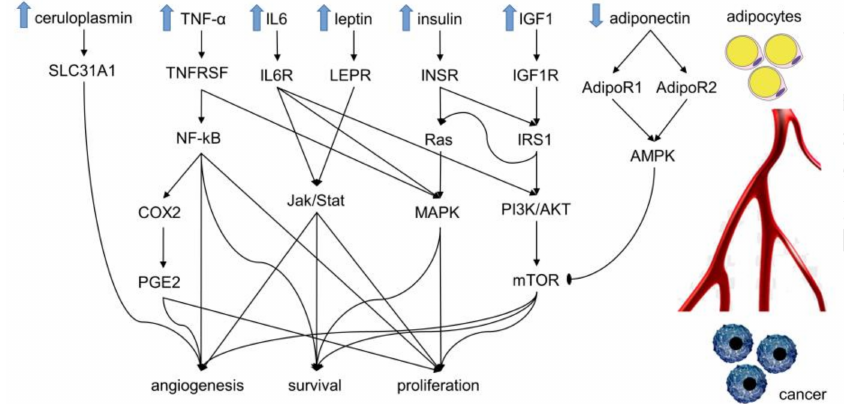
Figure 1. The pathway shows the influence of adipocytes on cancer. The arrows indicate induction or activation, the line ending with an oval segment (AMPK on mTOR) indicates inhibition. The substances released from adipocytes di ff use through the blood circulation and reach cancer cells where activate di ff erent cellular pathways. The latter lead to an increase of cell proliferation, survival and angiogenesis. IGF1: Insulin-like growth factor I. IGF1R: Insulin-like growth factor 1 receptor. INSR: Insulin receptor. IRS1: Insulin receptor substrate 1. BAD: Bcl2-associated agonist of cell death. MAPK: Mitogen-activated protein kinase. LEPR: Leptin receptor. ADIPOR1: Adiponectin receptor protein 1. ADIPOR2: Adiponectin receptor protein 2. VEGFA: Vascular endothelial growth factor A. AMPK: AMP-activated protein kinase. mTOR: Serine / threonine-protein kinase mTOR. CP: Ceruloplasmin. SLC31A1: High a ffi nity copper uptake protein 1. TNF: Tumor necrosis factor. TNFRSF: Tumor necrosis factor receptor superfamily. IL6: Interleukin-6. IL6R: Interleukin-6 receptor subunit alpha. PTGS2: Prostaglandin G / H synthase 2. PI3K: Phosphoinositide 3-kinases. AKT: serine / threonine kinase. HIF1A: Hypoxia-inducible factor